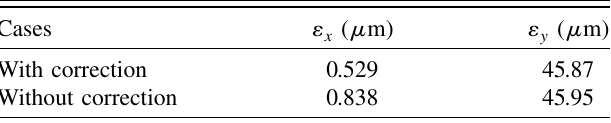
TABLE I. Transformation results with and without nonlinear correction